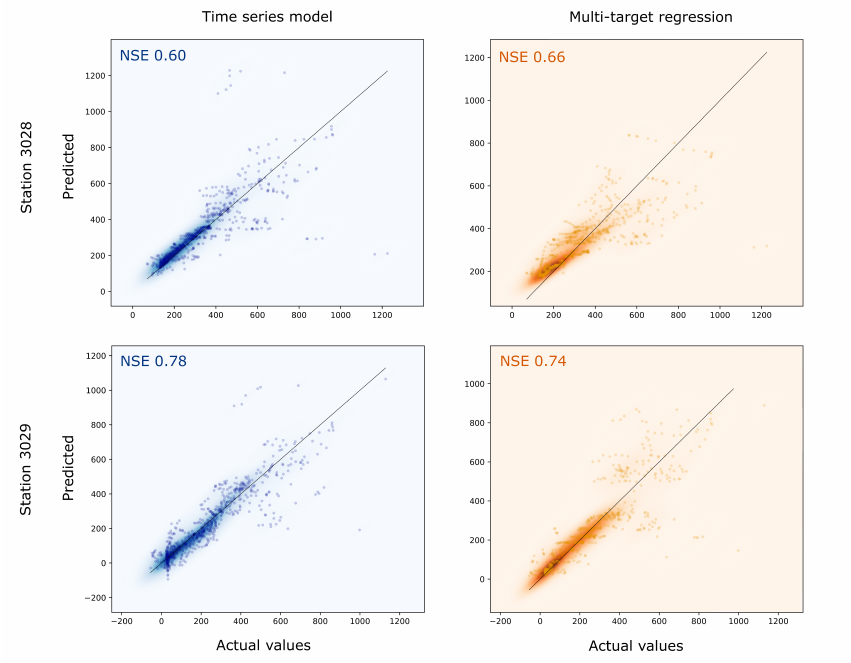
Figure 14. Actual values vs. predicted for the two hydro gauges. Time series and multi-target models forecasts are shown for validation part. Forecast horizon is seven days.